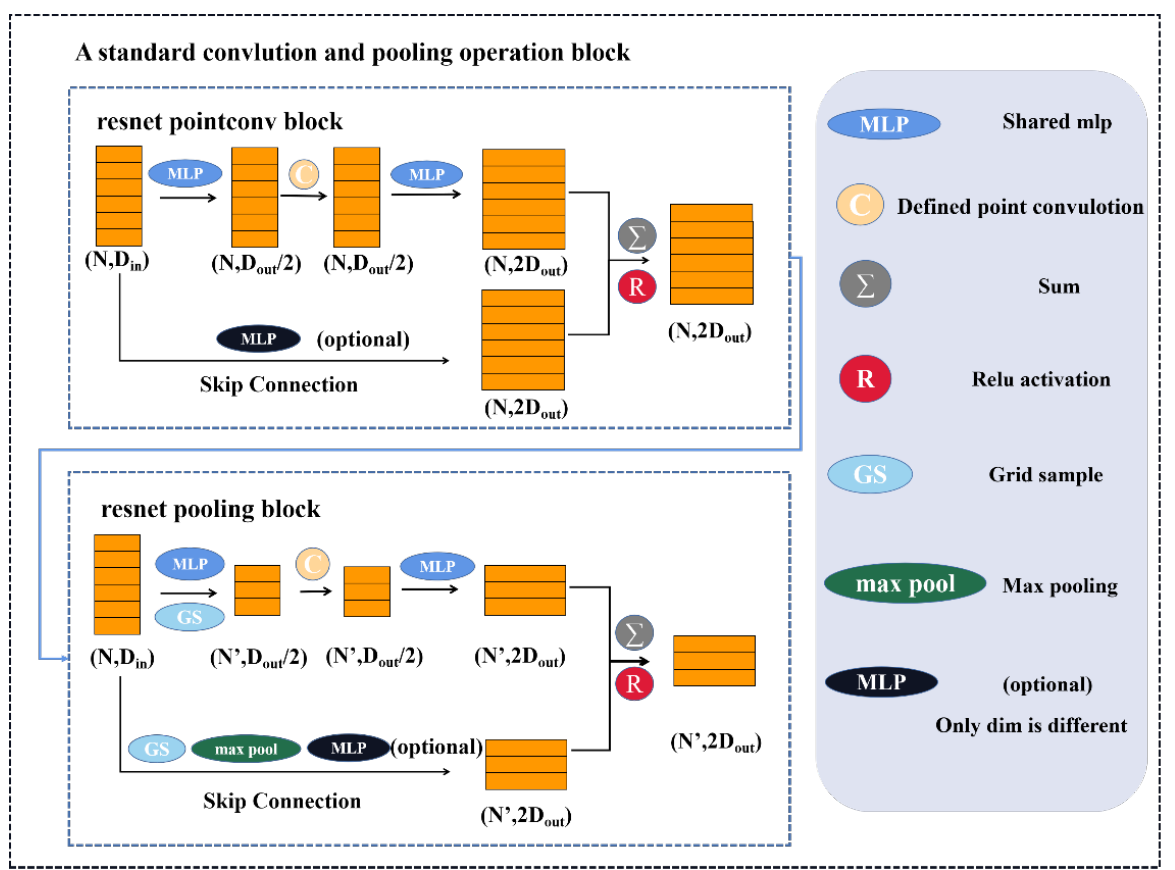
Figure 7. The convolution and pooling layers; the top panel is the convolution operation block.